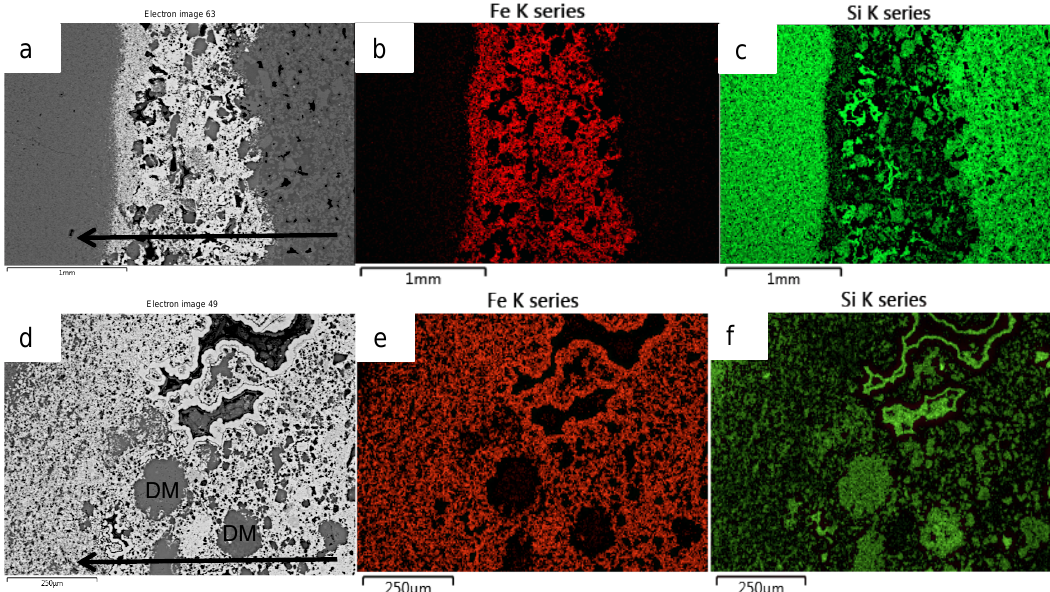
Figure 9. EDS electron micrograph showing major elemental composition of typical Fe bands alternating with Si-rich layers in the NFIF. Volcaniclastic detritus mostly present in the Fe-rich bands suggests precipitation during active submarine volcanism. By contrast, the Si-rich band grains that are of a homogenous fine-size composition and lacking volcaniclast suggest deposition during intervals of minimal volcanic activity. Arrows in (a) and (b) depict the direction of sedimentation, seen to proceed from an Fe-rich matrix mixed with large grains of volcaniclastic detritus (DM) to one composed essentially of very fine-grained Fe particles before transitioning into the very fine-grained Si-rich layer. An upward fining of the volcaniclastic particles in the Fe-rich layers transitions from one made up of volcaniclastic debris and hematite, to a mainly thin hematite-rich horizon at the top of this mixed layer (see Figs. S8–S11 for details). This concurrent occurrence of volcaniclast and Fe oxides, combined with the upward fining nature of the Fe-rich layers, suggests that the release and oxidation of Fe(II) coincided with the settling of hydrothermal debris resulting from the introduction of an enormous amount of reduced materials into the water column. The Fe-rich layer ceased forming as hydrothermal or volcanic release of Fe subsided, followed by deposition of the Si-rich layer. This repetitive cycle of events is observed for tens of meters laterally and vertically, stressing that the layers are not single isolated or post-depositional replacement events but chemical precipitates that sequentially sedimented out of the water column. Red color in (b) and (c) depicts Fe, and green in (c) and (f) depicts